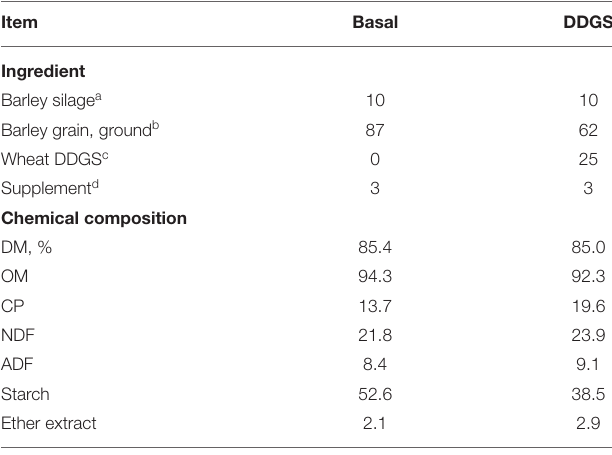
TABLE 1 | Ingredient and chemical compositions of the experimental diets (% of DM unless otherwise